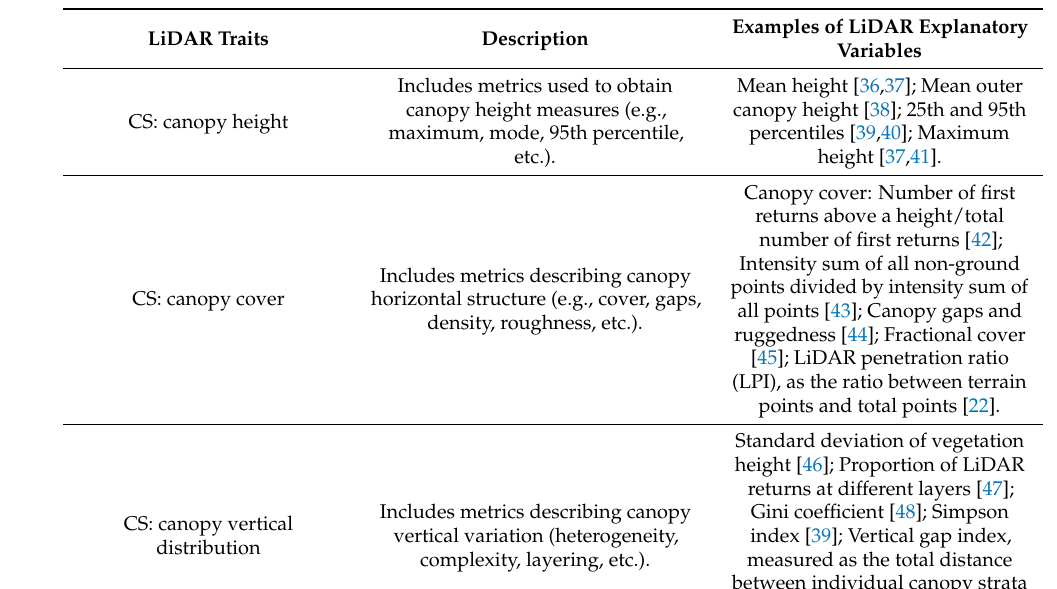
Table 1. LiDAR traits used to harmonize and classify the whole set of LiDAR metrics included in the reviewed papers (173), their meaning, and some examples. CS: canopy